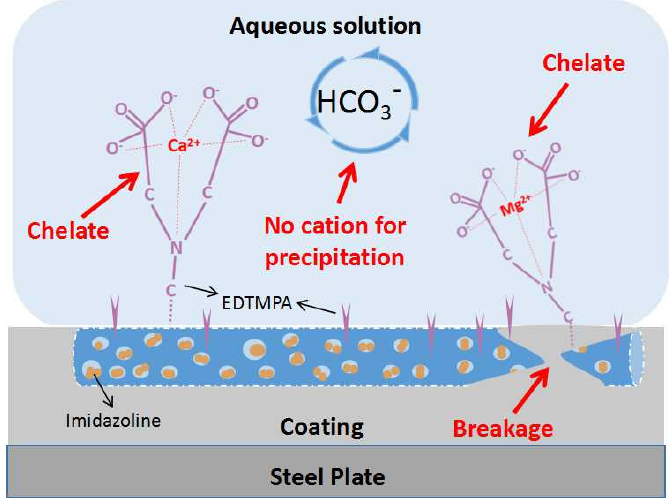
Figure 11. The scale inhibition mechanism of an iETiO 2 (w) epoxy coating.